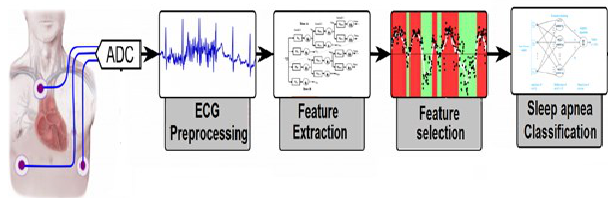
Fig. 2. The proposed OSA detection method.